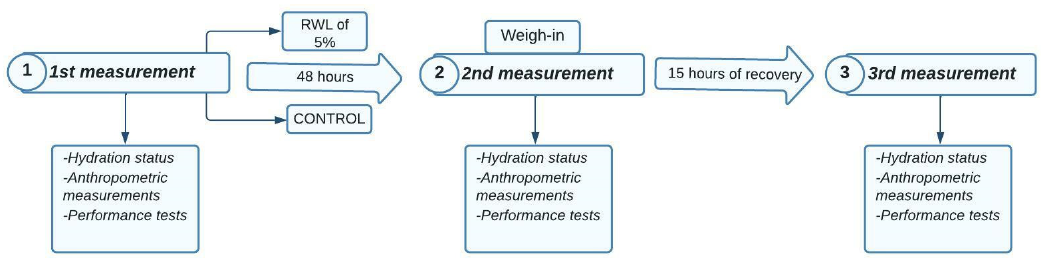
Figure 1. Design of the entire experimental protocol .